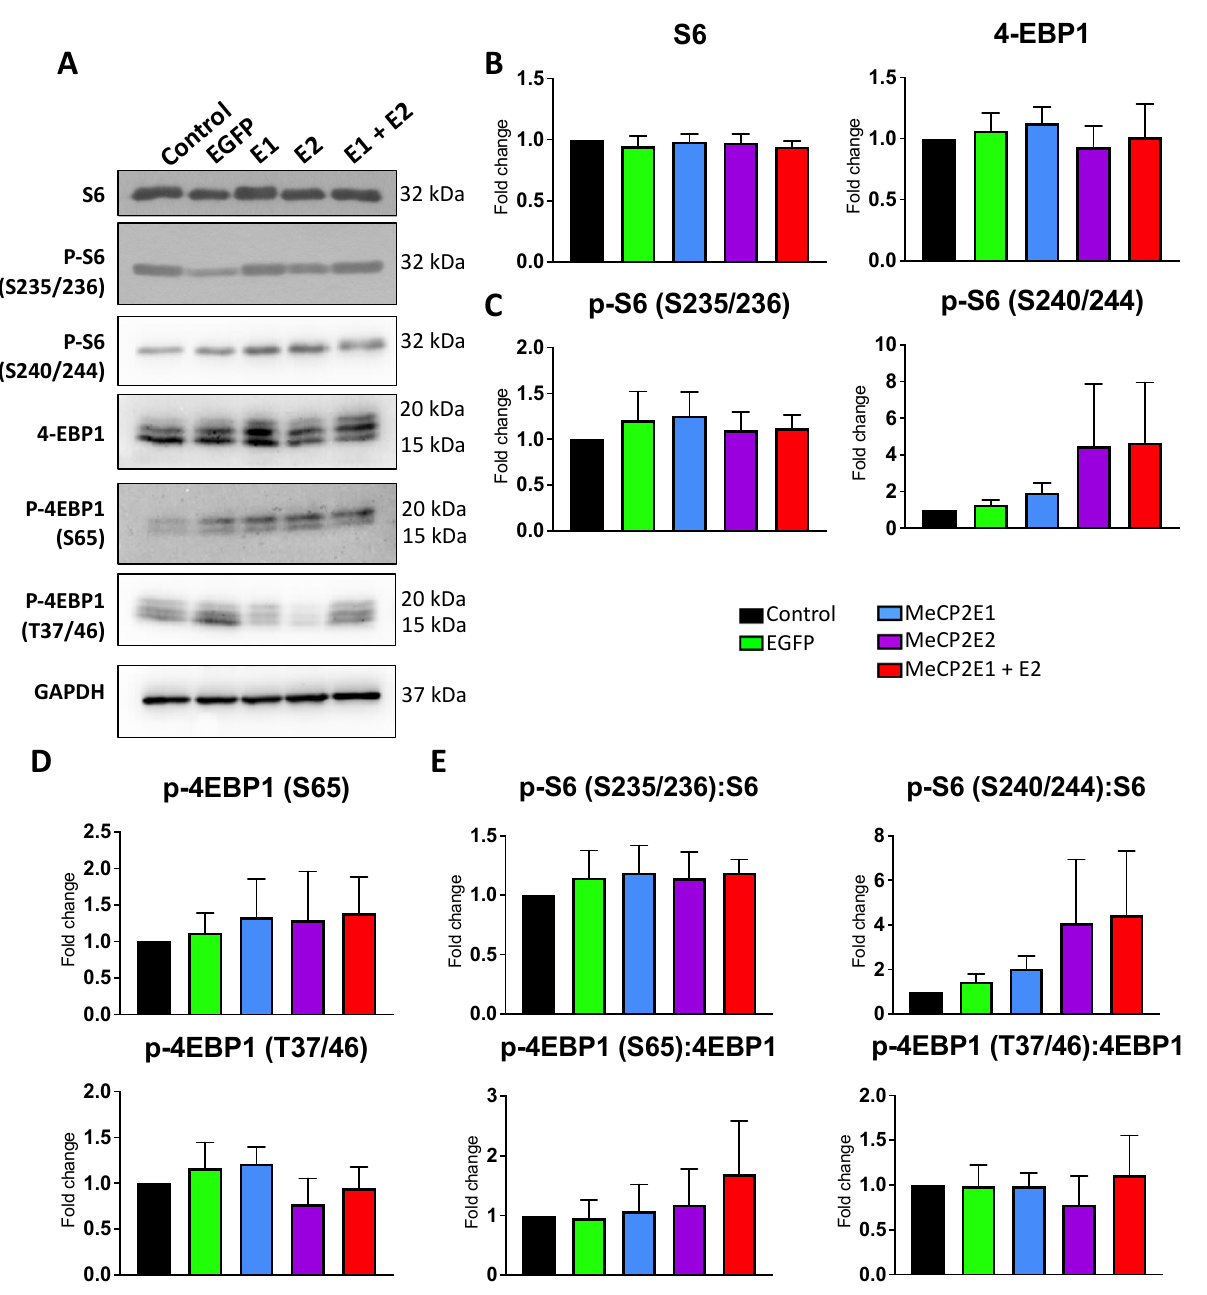
Figure 10. Protein analysis of ribosomal protein S6 and components of protein translation initiation in Daoy cells transduced with lentiviral vectors overexpressing MeCP2 isoforms. ( A ) Western blot analysis of the indicated proteins in non-transduced control Daoy cells, EGFP-transduced (EGFP), E1-transduced (E1), E2-transduced (E2), and E1 + E2-tranduced (E1 + E2) cells. ( B , C ) Quantification of the indicated total proteins from A. ( D , E ) Ratio analysis of phosphorylated proteins from A versus their non-phosphorylated pan proteins. n = 4–6 ( n = 4 for p-4EBP1 (S65), p-S6 (235/236); n = 5 for p-4EBP1 (T37/46), n = 6 for S6, p-S6 (240/244), n = 6 for 4EBP1), and data are reported as mean ± SEM. For ratio of phosphorylated proteins to their pan protein abundances (Part D ), samples from the same biological replicate were analyzed against the pan proteins from the same set. For the reported ratios, where n is different for the phosphorylated proteins versus their pan protein, n for the ratio would be equal to the lowest n within the phospho-pan protein pair.